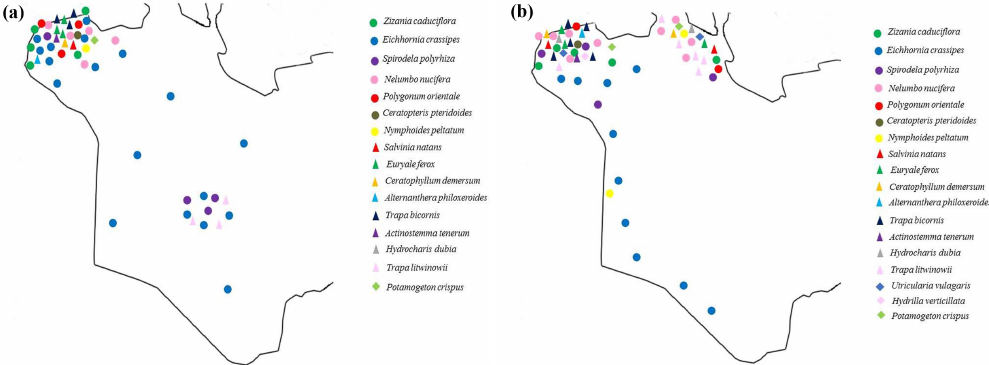
Figure 3. Distribution of macrophyte species in the western part of Longgan Lake for ( a ) September 2017 and ( b ) September 2018.